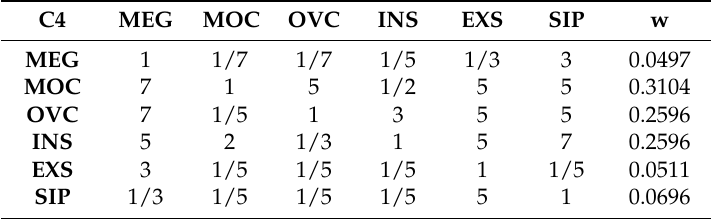
Table 7. Comparison of the six alternatives with regards to tampering avoidance (C4).